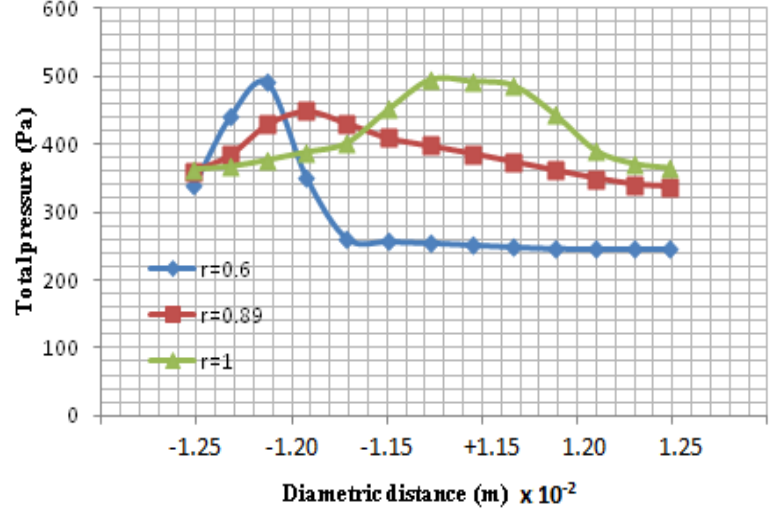
Figure 6. Density ratio affecting the diametric variation of total pressure of